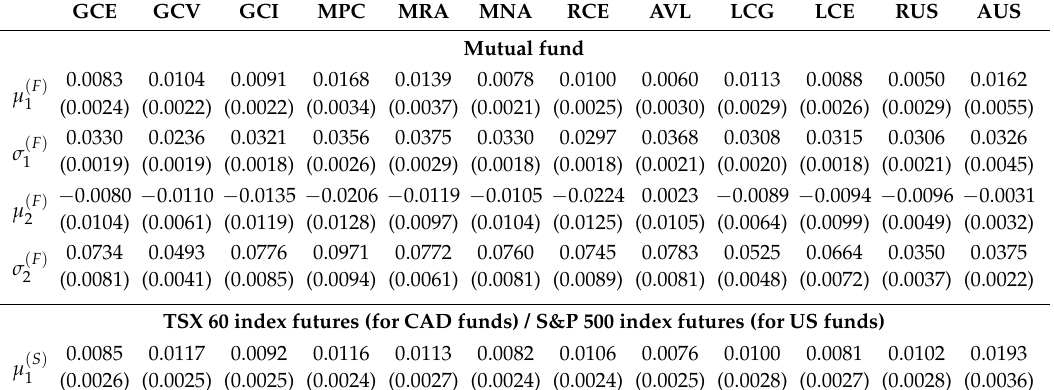
Table 2. Maximum likelihood estimation results for the bivariate lognormal two-state regime-switching model (1) for each respective mutual fund and the corresponding hedging instrument. Fund descriptions are provided in Table 1.